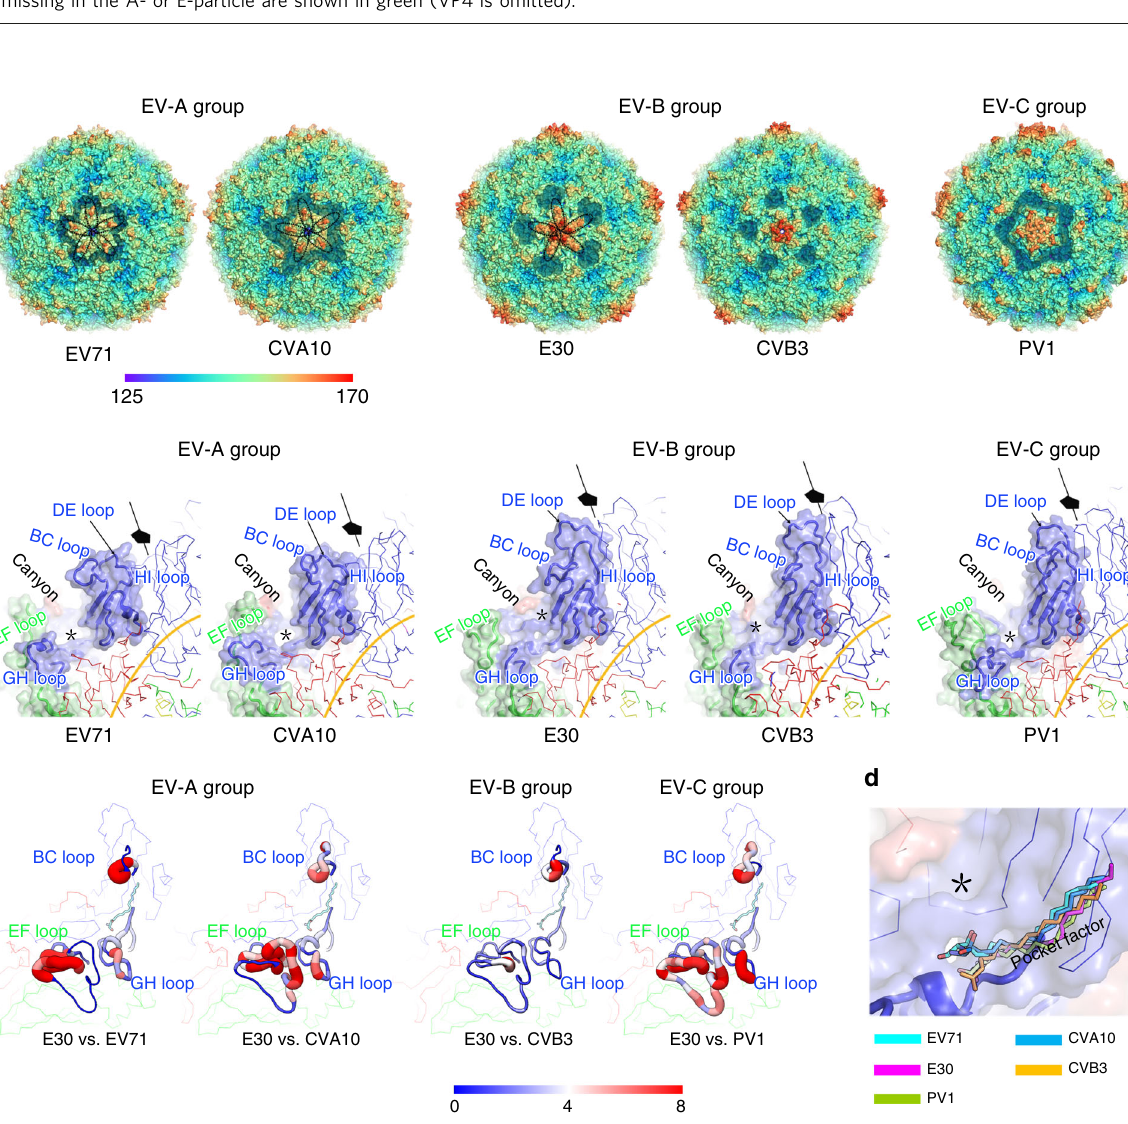
Fig. 2 Structure comparisons. a Comparison of capsid from E30 F-particle with those from representatives of enterovirus A (EV71-3VBS, CVA10-6AKS), B (E6-6ILP), and C (PV1- 1HXS) species. Capsids are rainbow-colored by radius from blue to red as shown in the color bar below. The canyon areas around fi vefold axes are highlighted by shadow and the ‘ star-shaped ’ protrusions surrounding the mesa are outlined with black dotted lines. b Surface of the biological protomer (VP1, blue; VP2, green; VP3, red) of representative particles. Loops forming the canyon walls (VP1 BC loop, VP1 GH loop, and VP2 EF loop) and “ mesa ” structures (VP1 DE loop) are labeled in corresponding colors. Hydrophobic pocket from each particle is marked with a black star. c Comparison of canyon from E30 F-particle with those from representative particles. As the same with 1f, structural differences are mapped onto the protomer of E30 F-particle; the thickness and color of the worm representation re fl ect the local deviation between the structures (from blue (0 Å) to red (8 Å)). d Comparison of hydrophobic pocket of E30 with those from representative particles. Pocket factors from representative viruses were aligned together within the hydrophobic pocket of E30. The color scheme adopted in ( c , d ) is the same as that in ( b